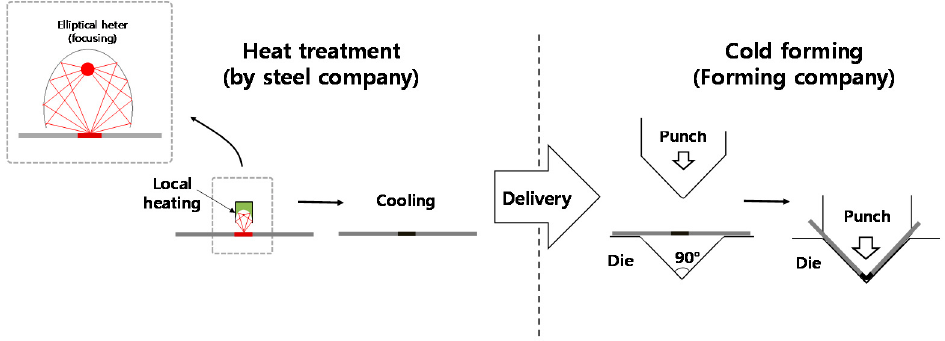
Figure 1. Concept of local heat-assistant cold forming.